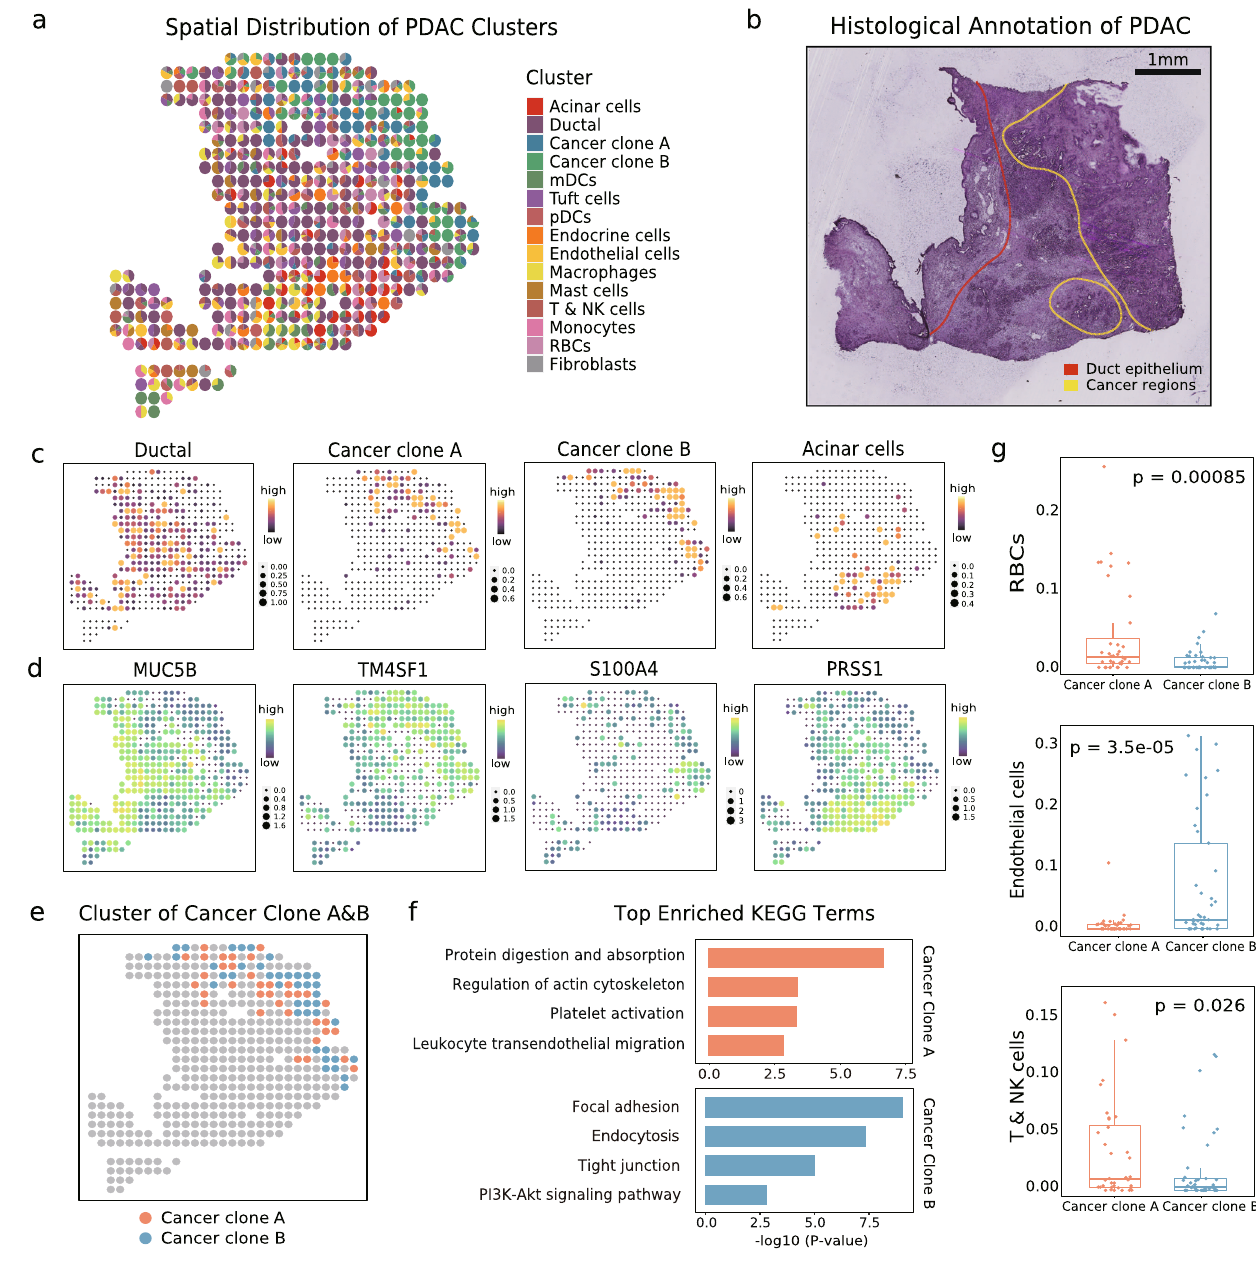
Fig. 7 | uniPort identi fi es distinct cancer subtypes in microarray-based spatial data.a Spatial deconvolution result of pancreatic ductal adenocarcinoma (PDAC). b Three manually segmented annotation of PDAC tumor cryosection on one ST slide. The red line circles the ductal epithelium region (left), and the yellow line circlesthecancerregion(right). c Proportionand distribution of typicalclustersin PDAC. d Expression of marker genes corresponding to clusters in c . e Distribution